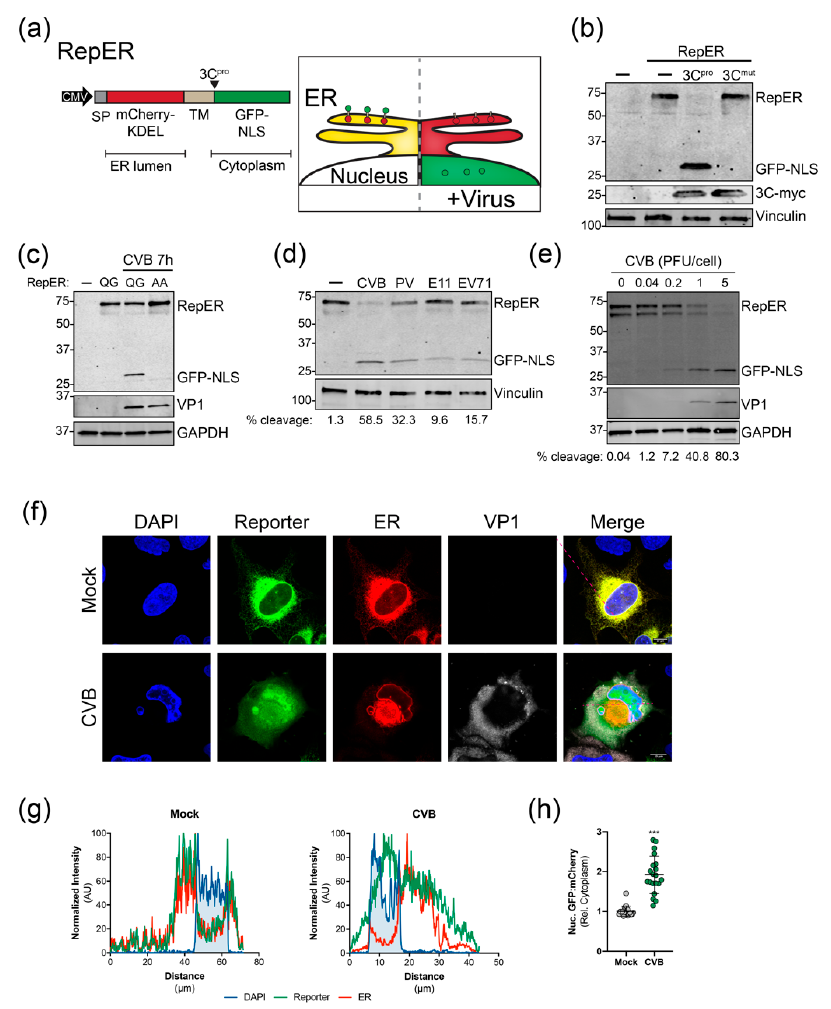
Figure 1. Validation of enterovirus plasmid-based reporters. ( a ) Left , RepER cassette driven by the CMV promoter. The RepER cassette contains an ER-localized mCherry containing a signal peptide (SP) and KDEL ER retention sequence followed by signal peptidase site fused to a transmembrane domain (TM) followed by the viral 3C protease (3C pro ) recognition sequence and GFP fused to a nuclear localization sequence (NLS). Right , Schematic of the predicted model for visualizing the ER and enterovirus infection. In uninfected cells (left) mCherry and GFP colocalize in the ER. During enterovirus infection (right,) viral 3Cpro cleavage releases the GFP-NLS, which translocates to the nucleus. ( b ) Immunoblot of GFP, myc, and vinculin from lysates from U2OS cells transfected with RepER and empty (-), CVB 3C pro -myc, or catalytically inactive CVB 3C pro -myc (3C mut ) expression plasmids. ( c ) Immunoblot for GFP, VP1, and GAPDH from lysates from CVB infected (100 PFU/cell) U2OS cells transfected with RepER or RepER containing an AA mutation to the QG in the 3C pro